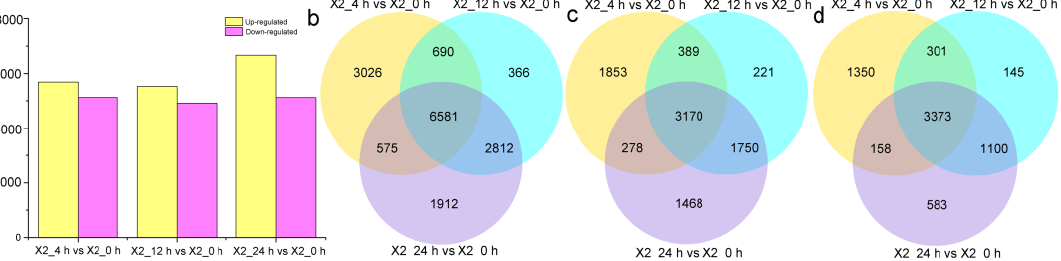
Figure 2. Statistical analysis of all identified DEGs in response to cut-wounding at different times after cutting. ( a ), Statistical chart of DEGs of transcriptomes in response to cut-wounding at 4 h, 12 h, and 24 h after cutting; ( b – d ), Venn diagram of total DEGs ( a ), up-regulated DEGs ( b ) and down-regulated DEGs at different times after cutting.